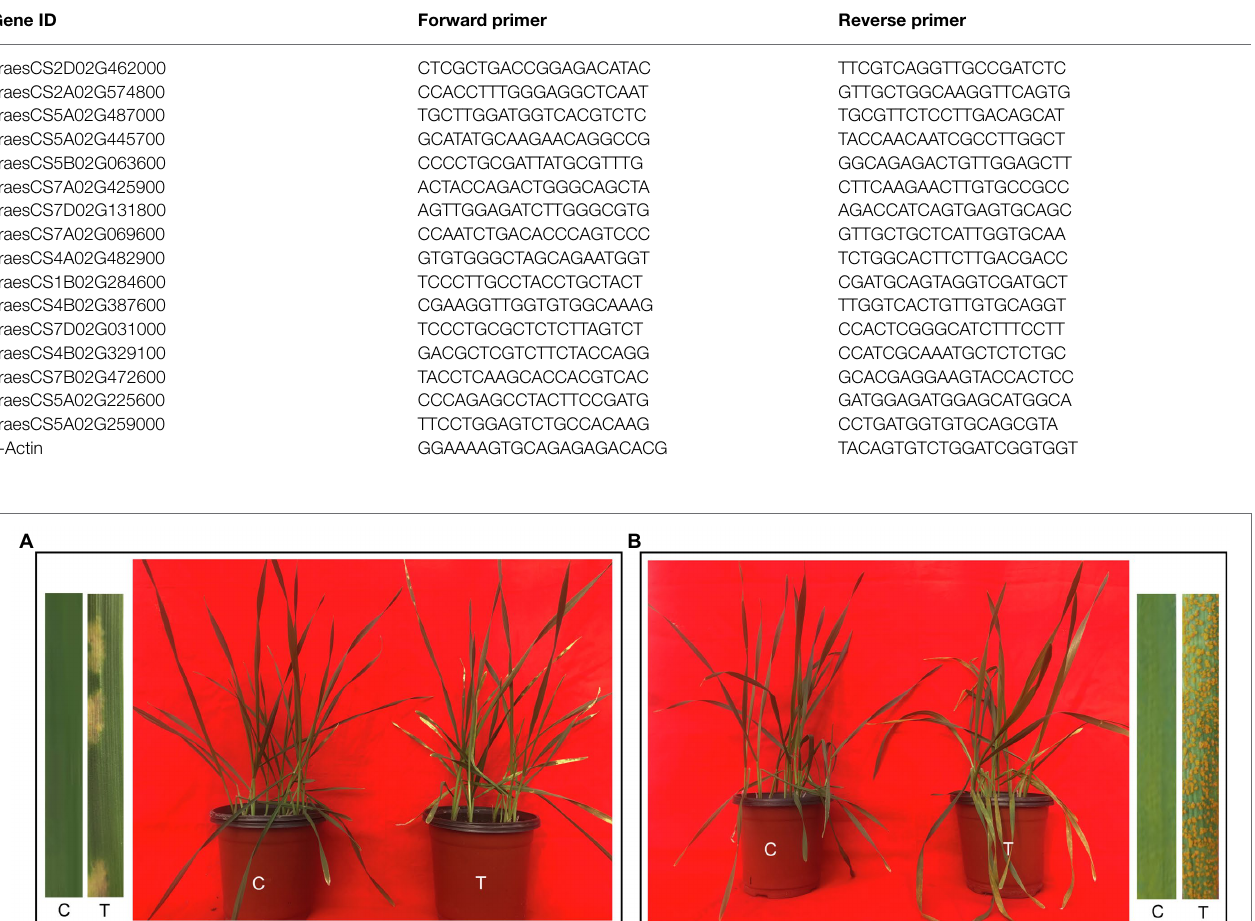
TABLE 1 | Primers used for validation of RNA-seq values by qRT-PCR.